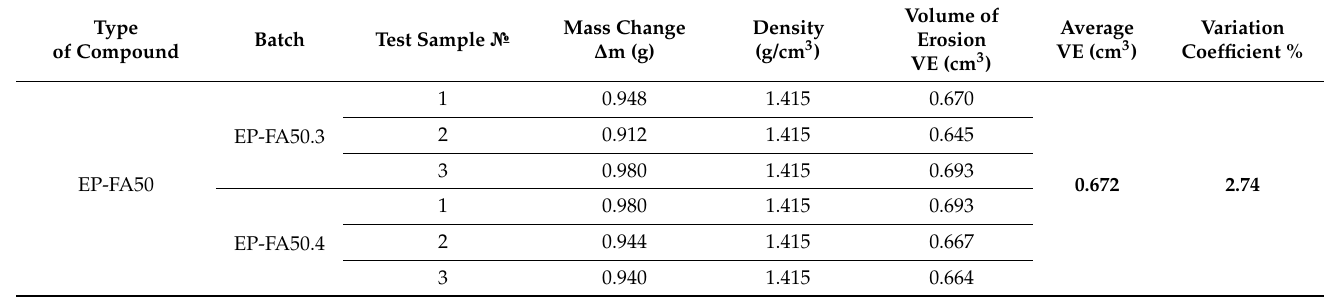
Table A14. Wear of filled epoxy binder (EP-FA50) at 23 ◦ C at an impingement angle of 45 ◦ .